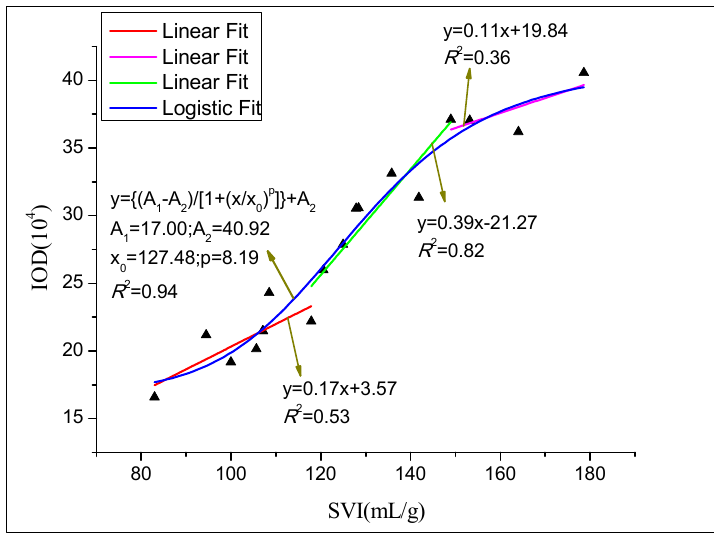
Figure 8. Quantification relationship between SVI and integral optical intensity (IOD).